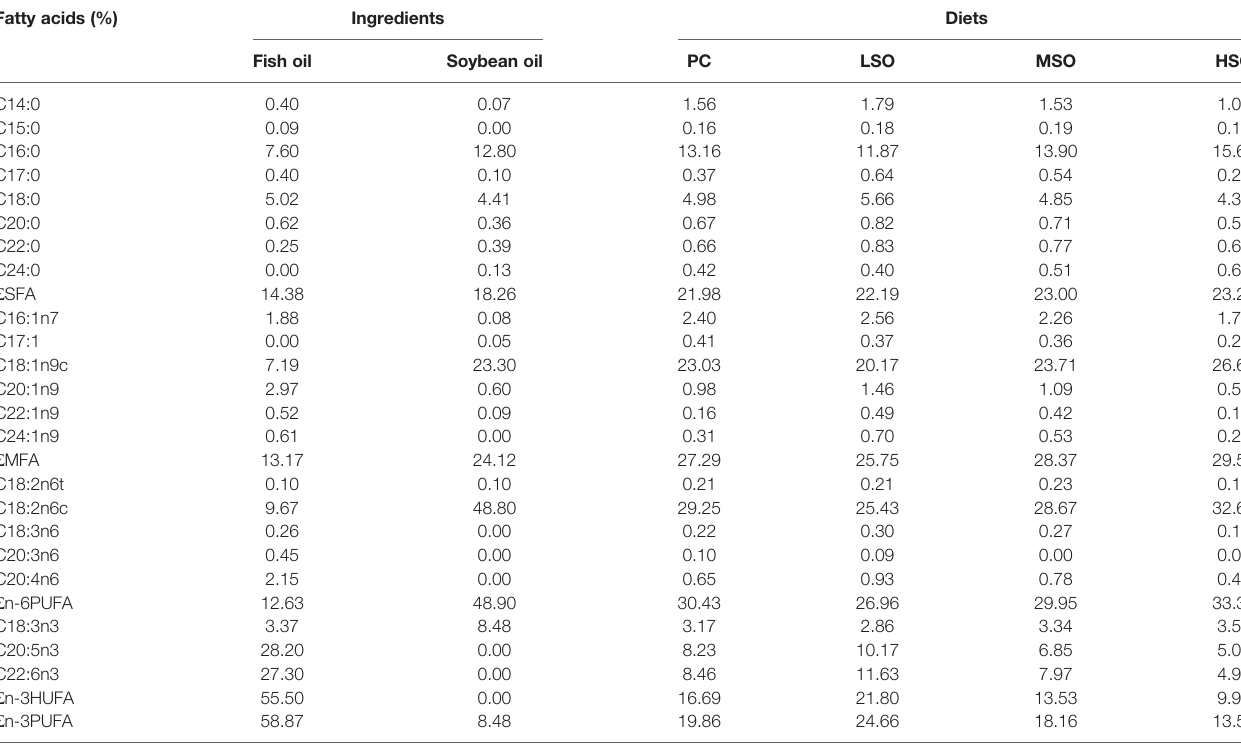
TABLE 3 | Fatty acid compositions of ingredients and diets used in this study (dry matter basis). Fatty acids (%)